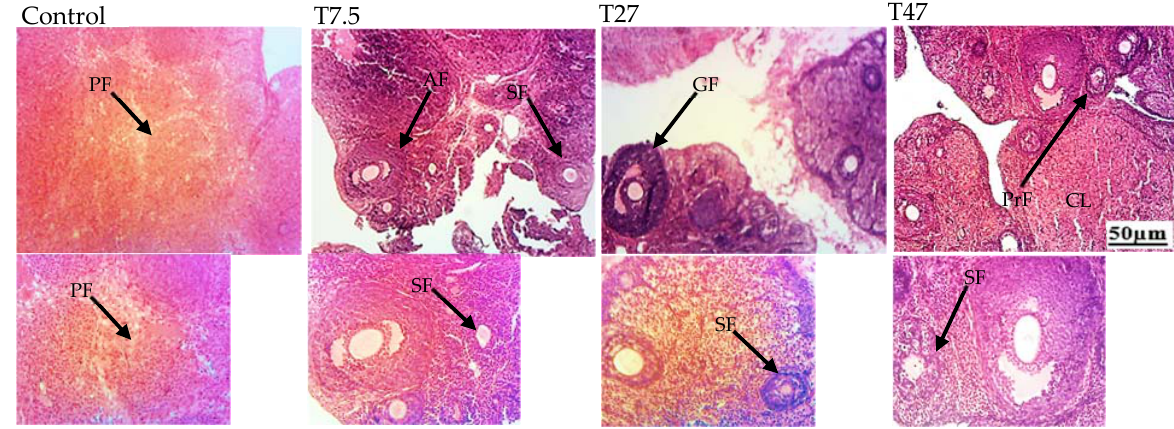
Figure 6. Microphotographs (25 × and 200 × ) of hematoxylin/eosin-stained sections of ovaries of immature female Wistar rats after 40 days of treatment. Control = animals receiving vehicle (distilled water, 10 mL/kg BW); T = rats treated with tartrazine at dose of 7.5; 27, and 47 mg/kg BW. Results are shown as a mean ± SEM, n = 5. PF = primordial follicle, PrF = primary follicle, SF = secondary follicle, AF = Antral follicle, GF = Graafian follicle, CL = corpora lutea.